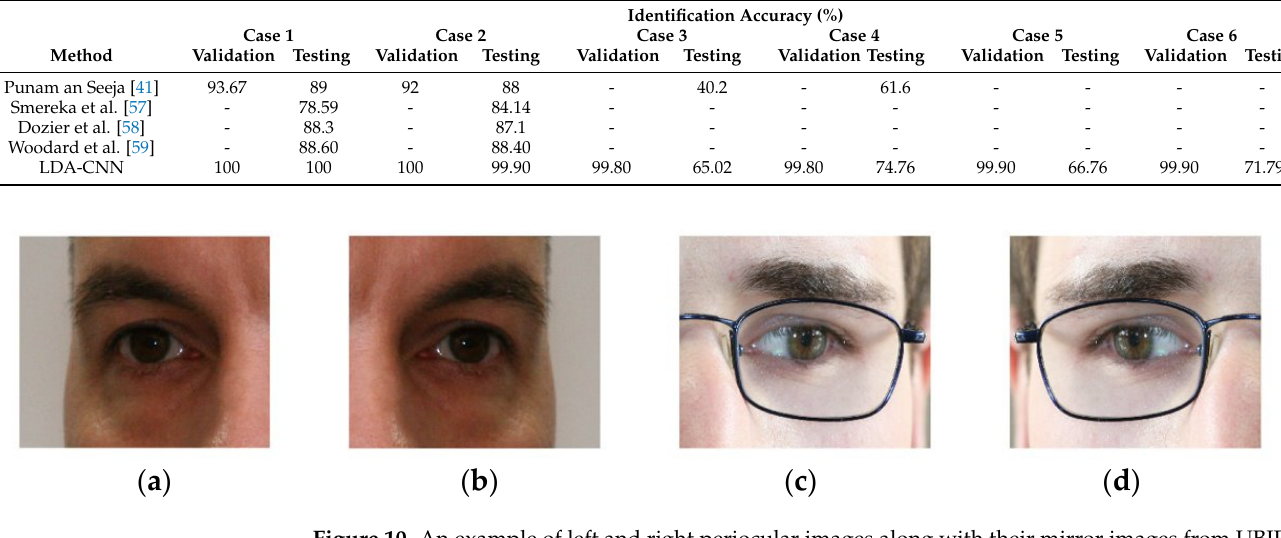
Table 10. Comparison of the results of the LDA-CNN model with other existing methods on cross-eye experiments on UBIPr using the protocol in Table 9.